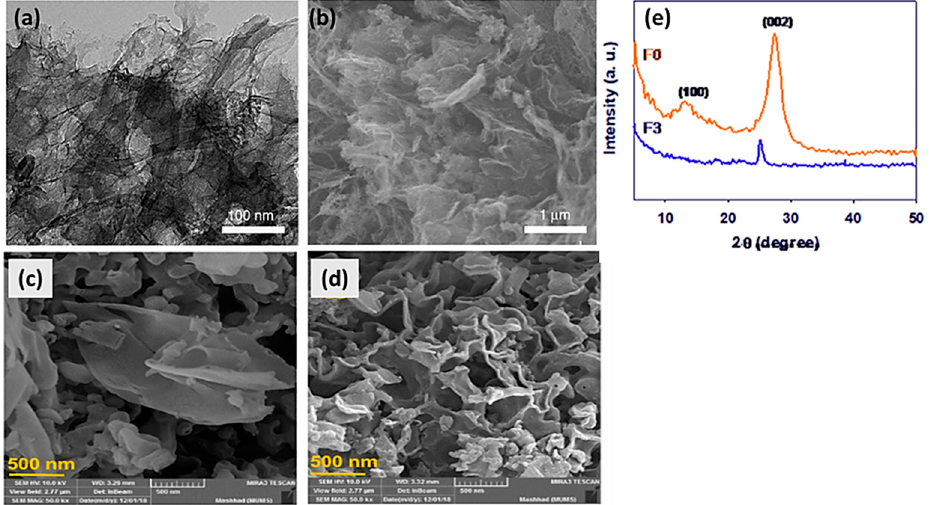
Figure 2. Nanoporous g-C 3 N 4 : ( a ) TEM images of g-C 3 N 4 nanoporous; ( b – d ) SEM micrographs, ( e ) XRD profile of g-C 3 N 4 [38].